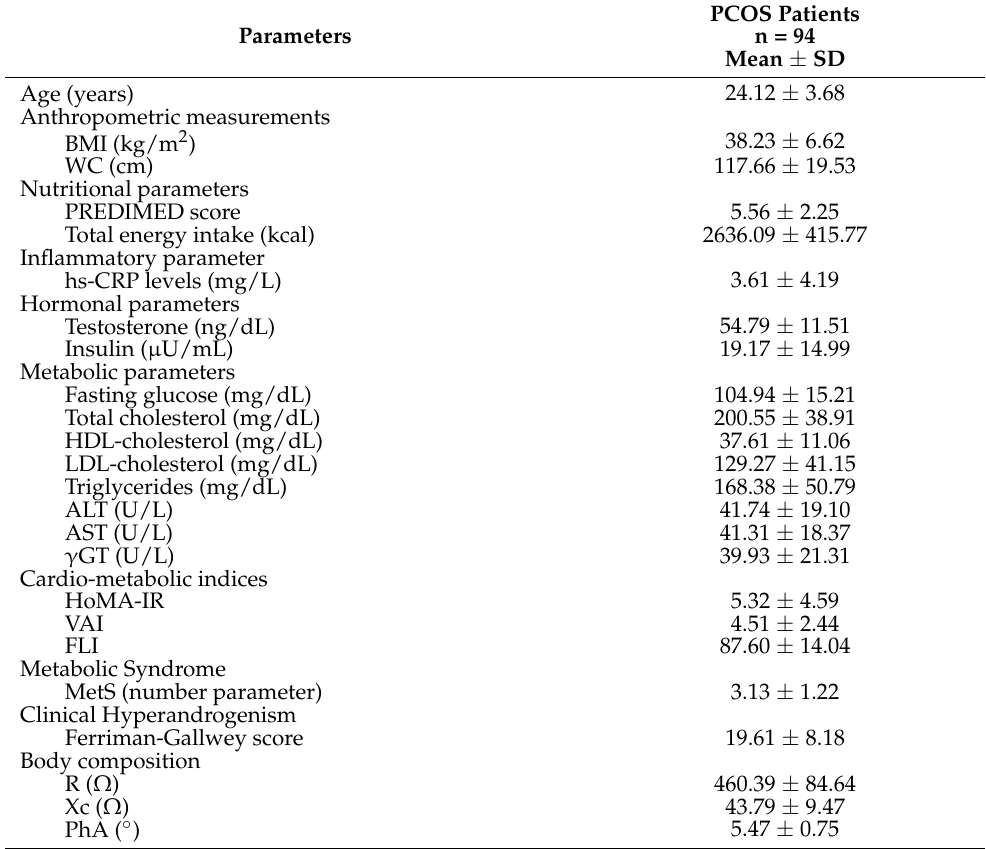
Table 1. Parameters evaluated in the study in PCOS patients.